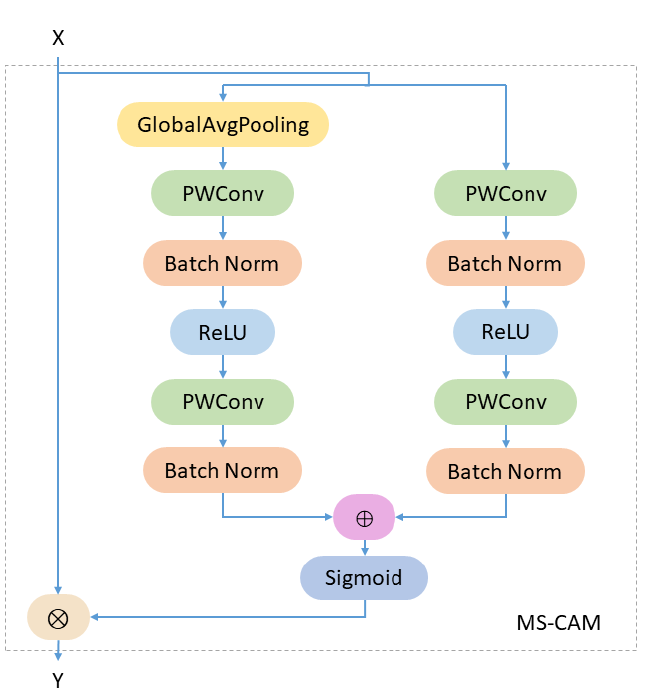
Figure 5. The main structure of MS-CAM [7].